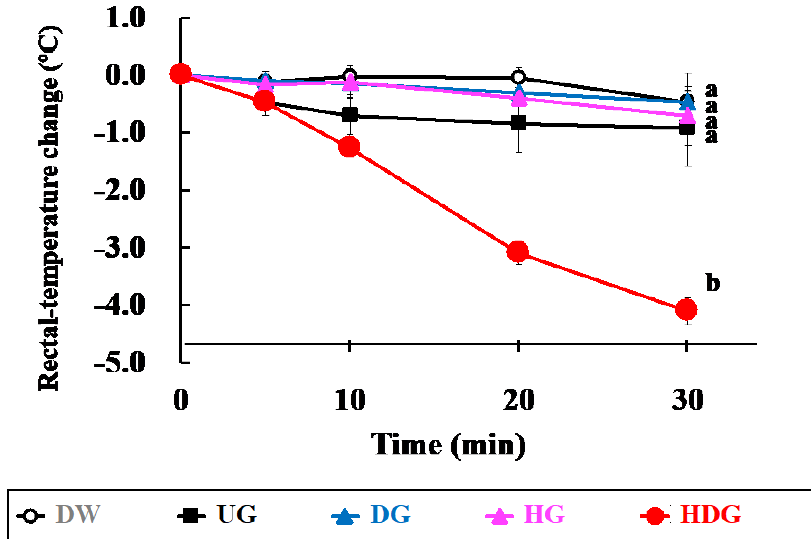
Figure 4. Change in the rectal temperature of mice after intraperitoneal challenge of each gliadin followed by cutaneous sensitization with the corresponding gliadin. Values with different letters at 30 min are significantly different at p < 0.01 based on the Tukey–Kramer test. Each value is the mean of eight experiments with SE shown as a vertical bar.